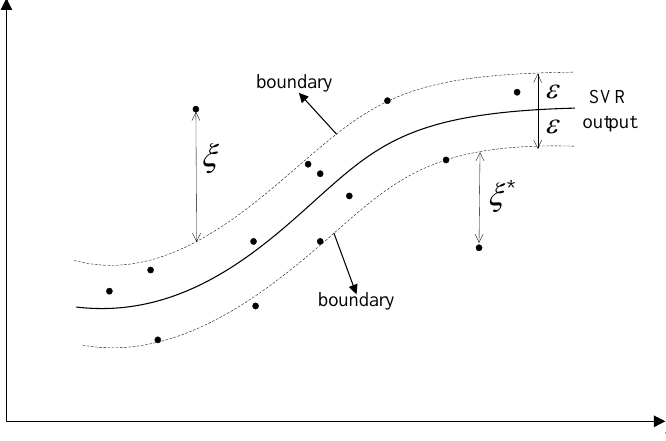
Figure 2. Graphic description of the (cid:15) -SVR model for a linear